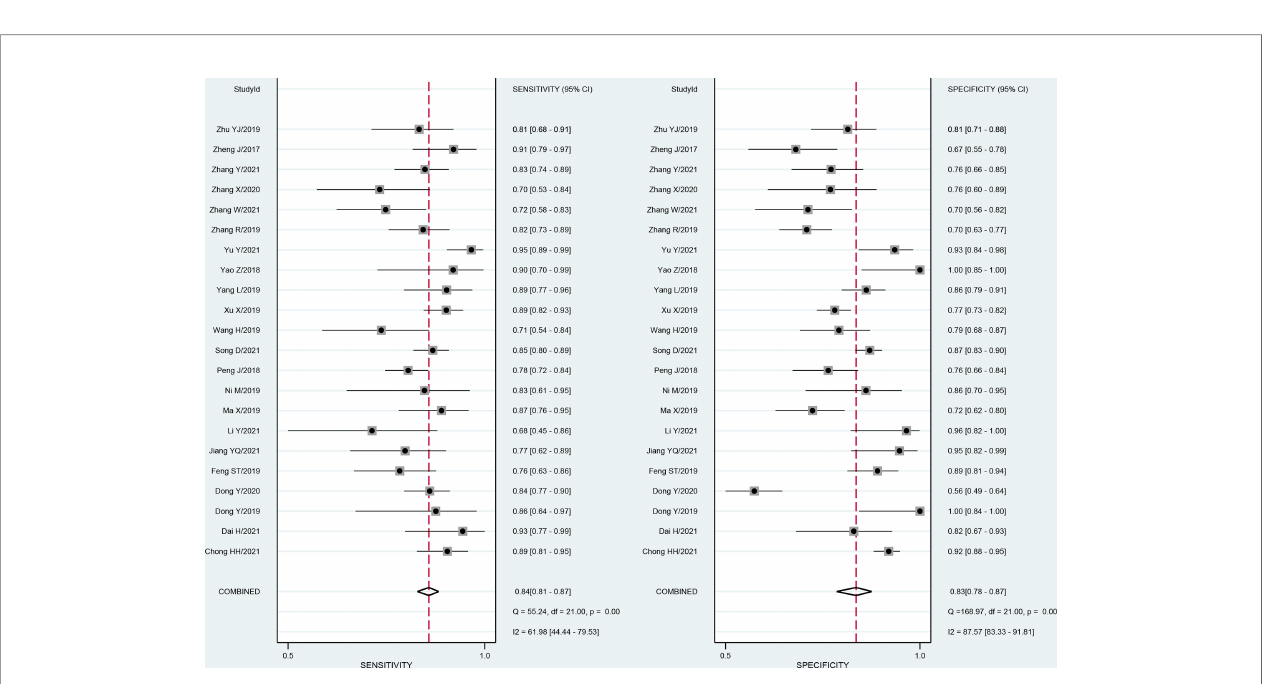
FIGURE 3 | Deeks ’ funnel plot shows no asymmetry and the presence of publication bias. Numbers in circles refer to the study ID. ESS, effective sample size.